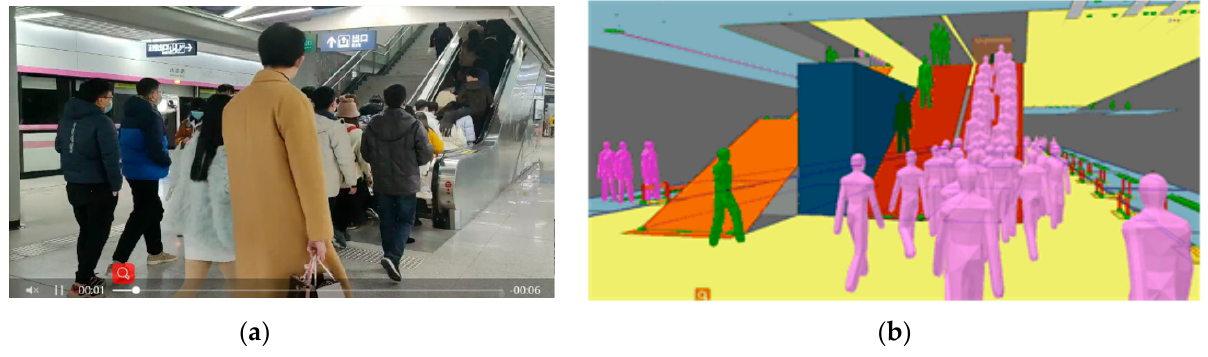
Figure 11. Observed and simulated pedestrian distribution at the stairway of the platform floor: ( a ) Observed result; ( b ) Simulation result.